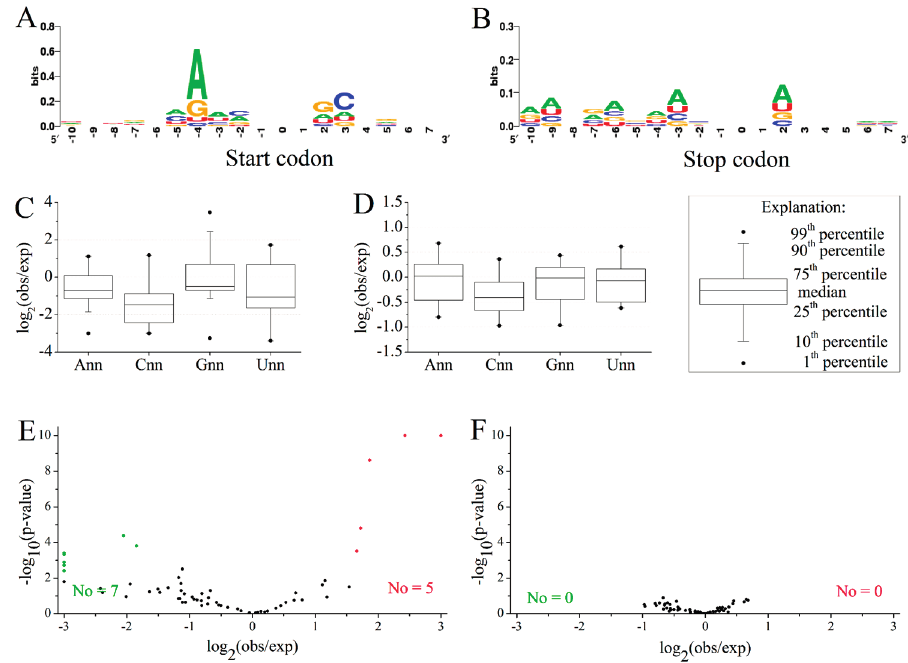
Figure 4. Logo analyses of start and stop codon contexts and the codon bias following AUG in M. amblycephala . ( A , B ) Logo analyses of 18 nucleotides around the start codon ( A ) and stop codons ( B ). The vertical axis represents the conservation at a certain position (measured in bits). The horizontal axis represents the nucleotide position around the start codon or stop codons. For mapping convenience, the start and stop codons were removed from the resultant map; ( C , D ) Distribution of the ratio of observed frequency to expected frequency in different types of codons following the start codon AUG ( C ) and non-start internal codon AUG ( D ); The X axis shows the types of codons, where n represent A, G, C or U; ( E , F ) The relationship between observed frequency and expected frequency of 61 codons following the start codon AUG ( E ) and non-start internal codon AUG ( F ). The red, green and black spots represent the preferred codons, avoided codons and unbiased codons, respectively. The lowest p -value was set to 1 × 10 − 10